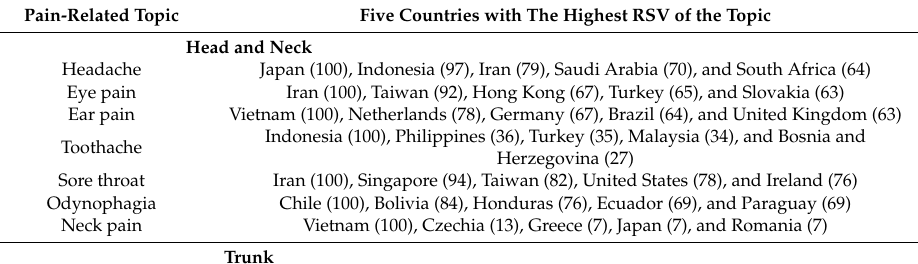
Table 2. Mean relative search volume (RSV) of five countries with the highest non-adjusted RSVs for a